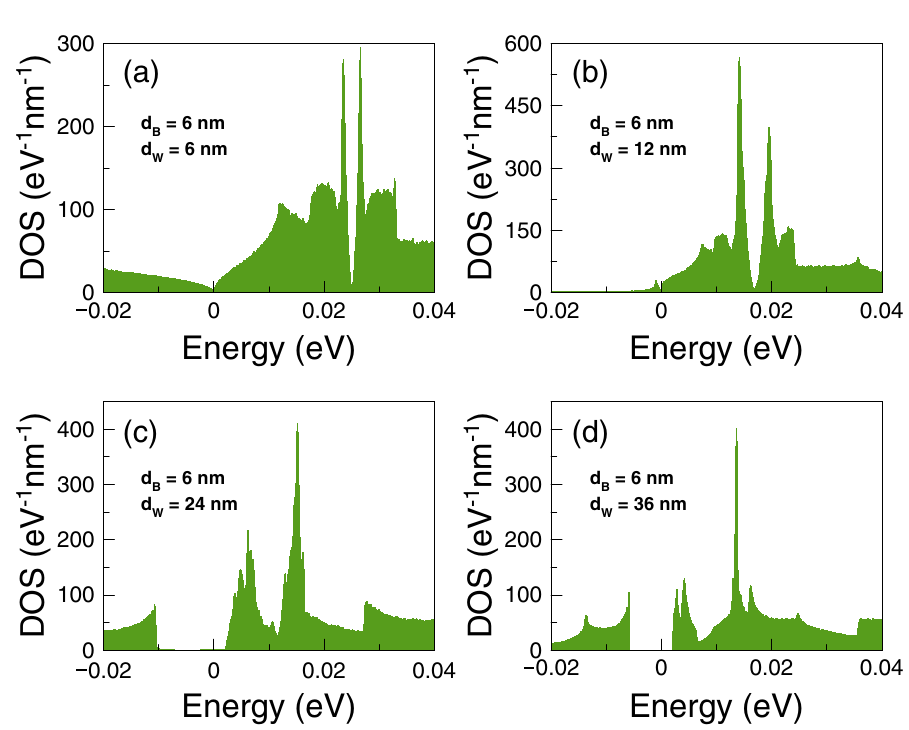
Figure 8. Density of states versus the energy for gapless bilayer graphene single barriers of d B = 6 nm. Here, the width of the well region d W is varied to mimic the conditions for single barriers: ( a ) d W = 6 nm, ( b ) d W = 12 nm, ( c ) d W = 24 nm and ( d ) d W = 36 nm. The height of the barrier is V 0 = 50 meV. As d W increases the electron states are accumulated around the energy region in which the Fano resonances are